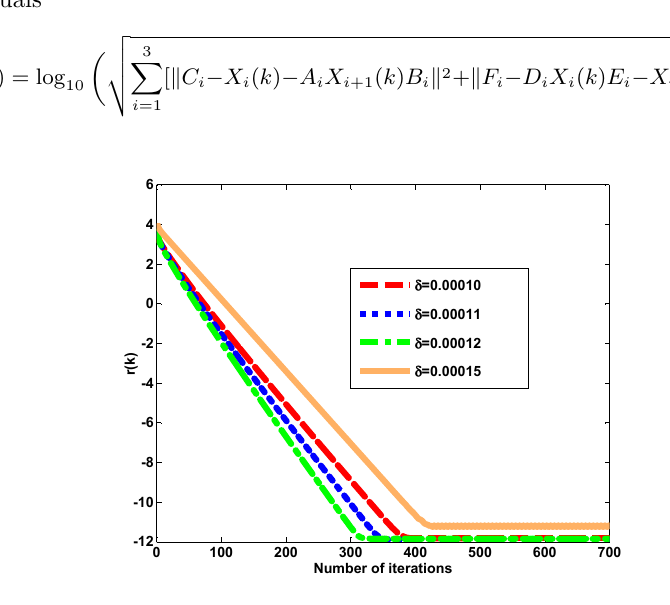
Figure 2. The residuals for Example